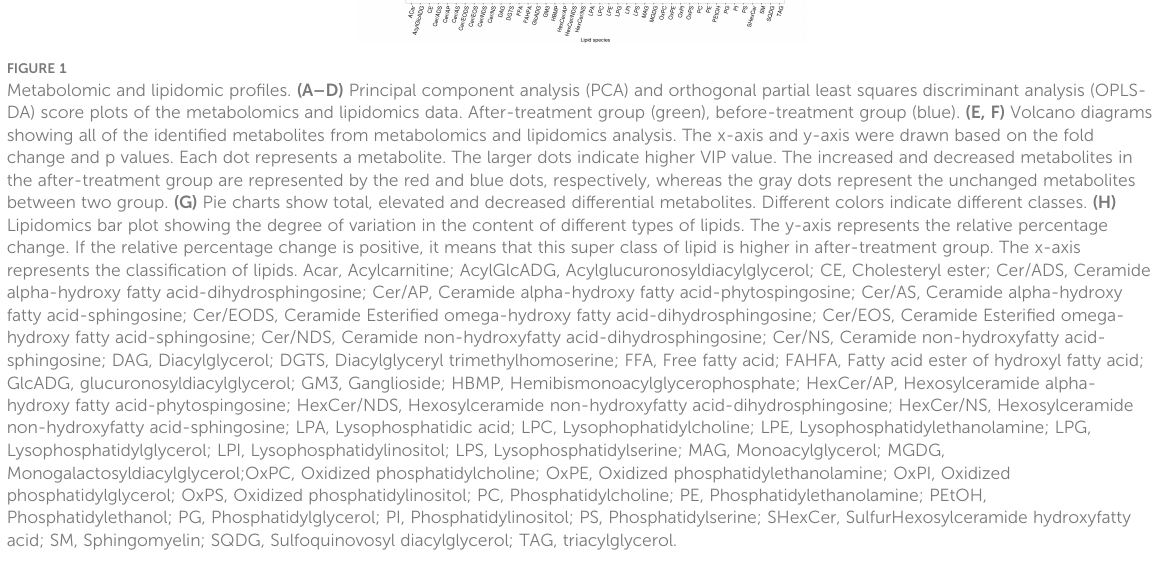
0.958 and Q 2 = 0.744 in the metabolomics analysis and R 2 Y = 0.961 and Q 2 = 0.761 in the lipidomics analysis, suggesting that